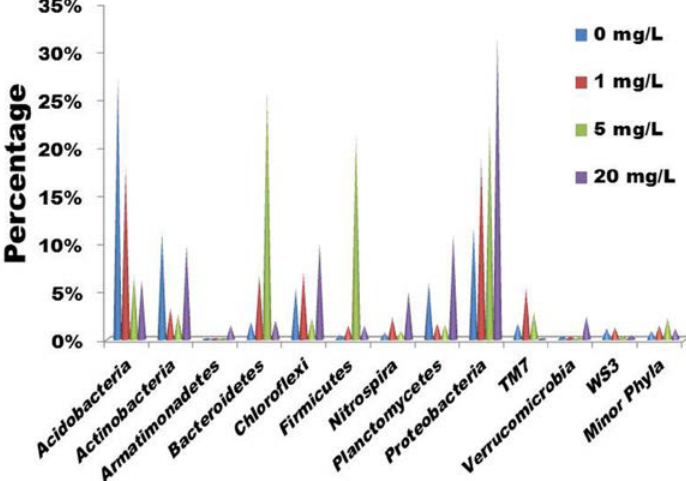
Figure 1. Abundance of various bacterial phyla in sludge after 6 days treatment with different concentrations of tetracycline (0~20 mg/L). The filtered pyrosequencing reads were classified using RDP Classifier at a confidence threshold of 80%. The relative abundance is presented as the percentage of each phylum in total effective reads of the corresponding